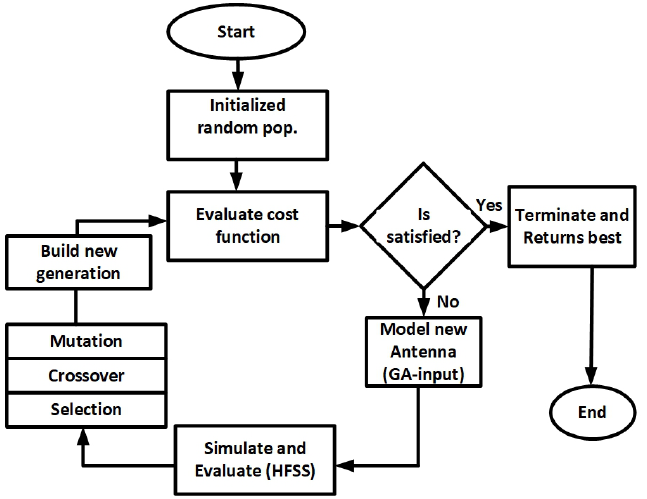
Figure 2. Flowchart of genetic algorithm implementation in antenna optimization.